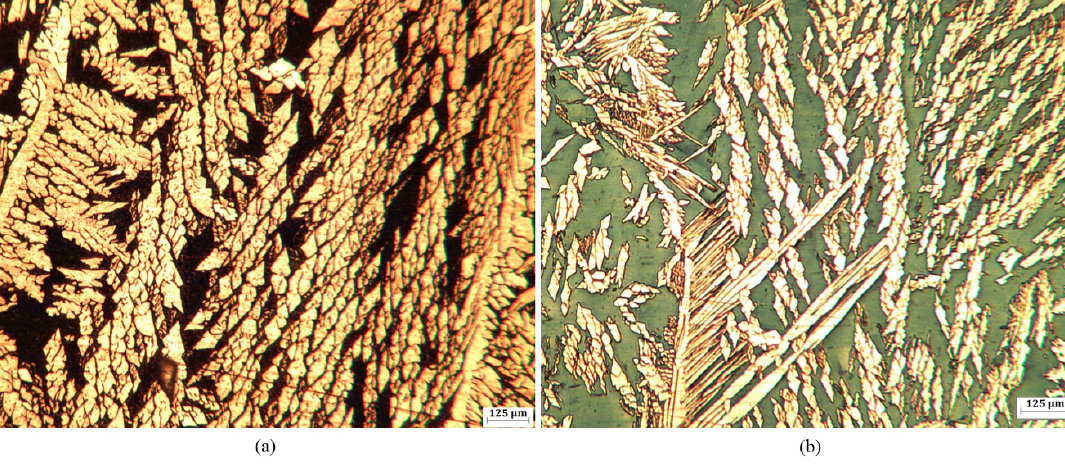
Figure 20. Microstructure from the 2205 DSS FZ: (a) shielding gas A (b) shielding gas B. (2.6 kJ mm –1